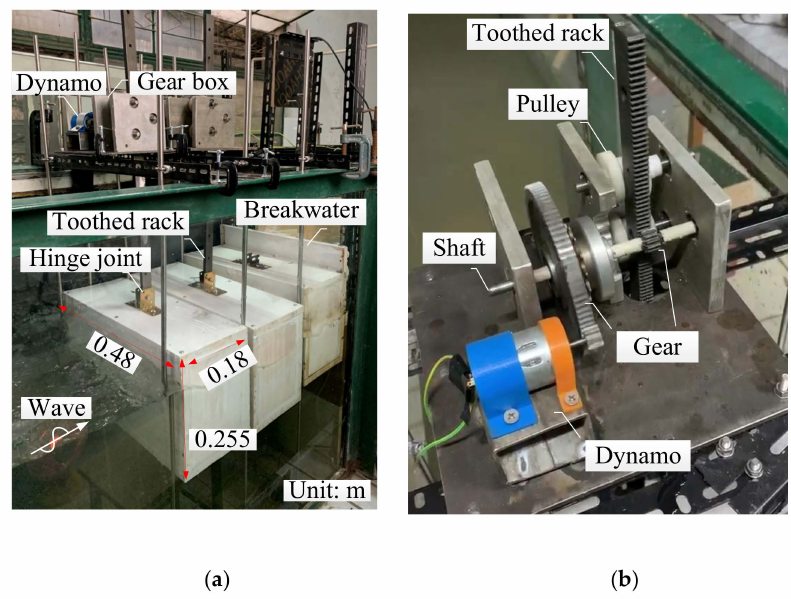
Figure 2. Schematic diagram of the physical model and its installation in the wave tank: ( a ) general view of the whole model; ( b ) general view of the gear box and